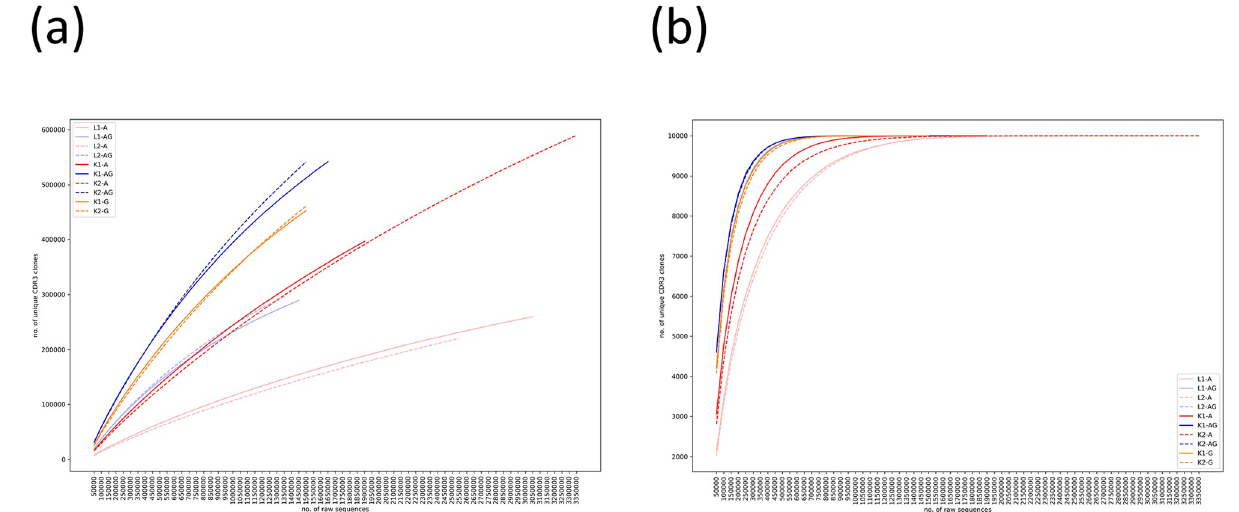
Fig 7. Rarefaction curves of (a) all and (b) top 10,000 unique CDR3 clones.